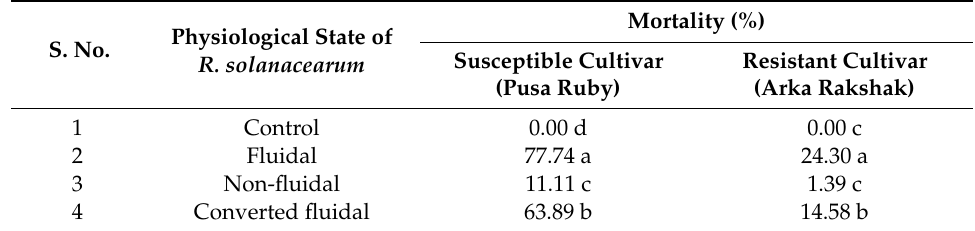
Table2. Mortalityinthetomatoplantsduetoinoculationdi ff erentphysiologicalstatesof R.solanacearum .